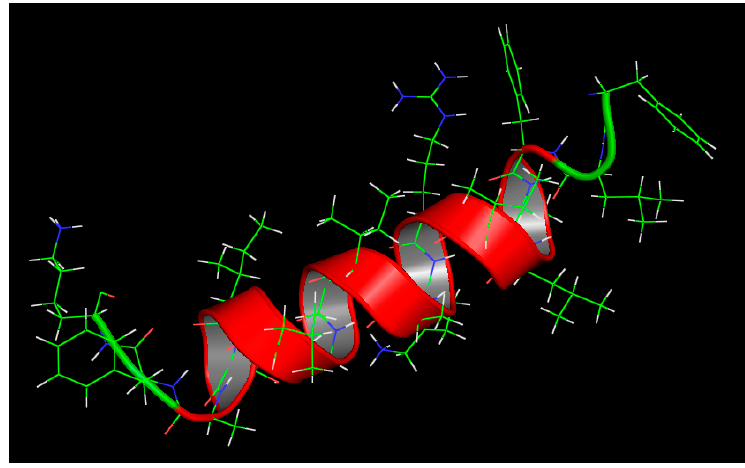
Figure 1. Accelrys ® Discovery Studio A3’s three dimensional model visualization. The visualization clearly indicates a continuous uninterrupted alpha helical structure.